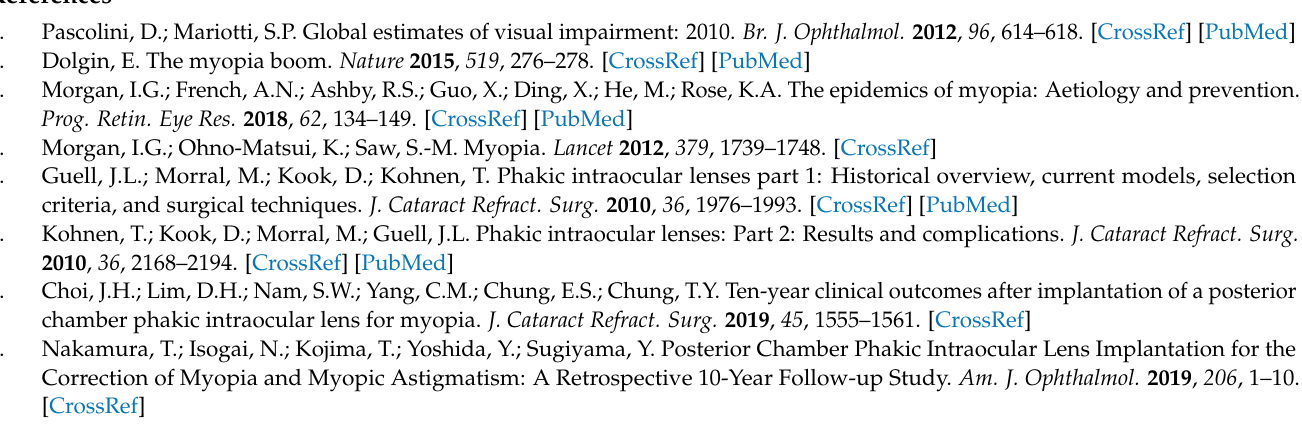
Table S1: Intraocular lenses implanted during cataract